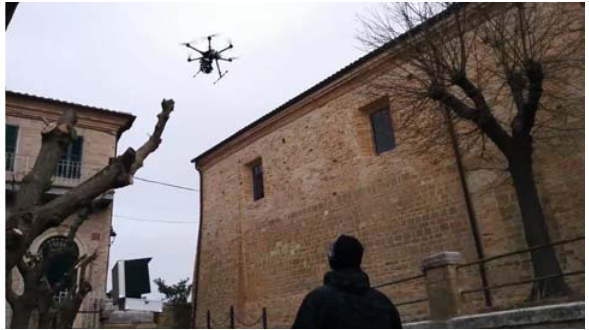
Figure 6. The UAV flying around the